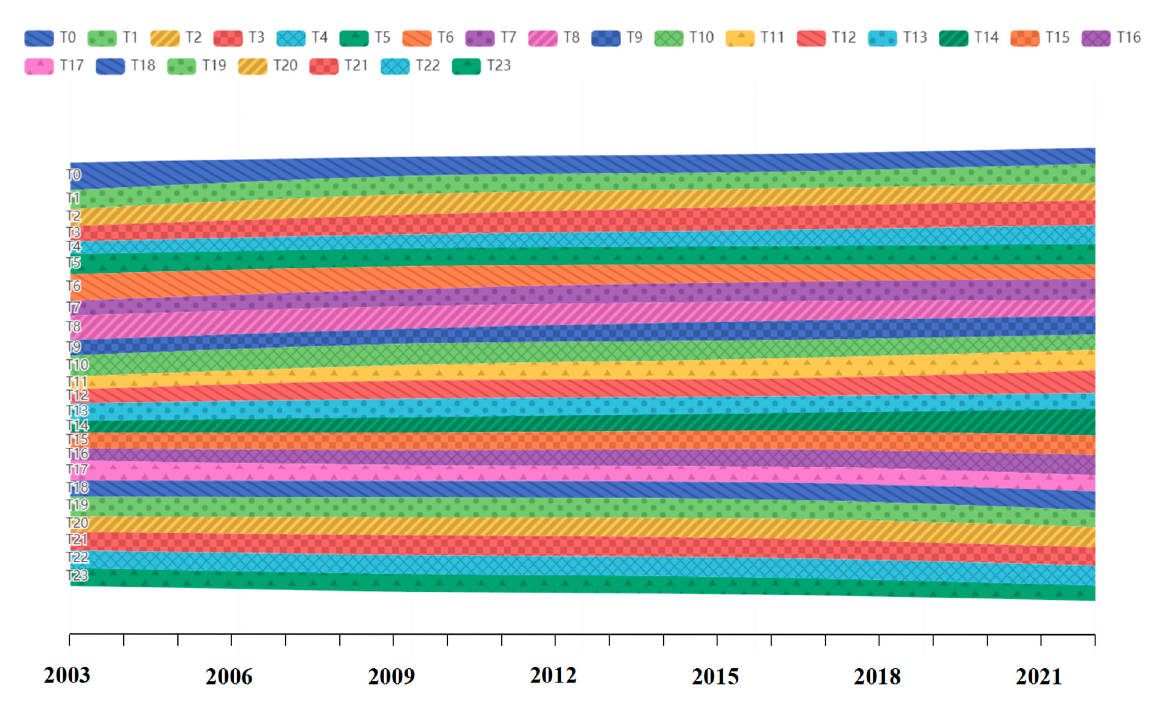
Figure 4. River map of the evolution of CCUS patent topic heat.